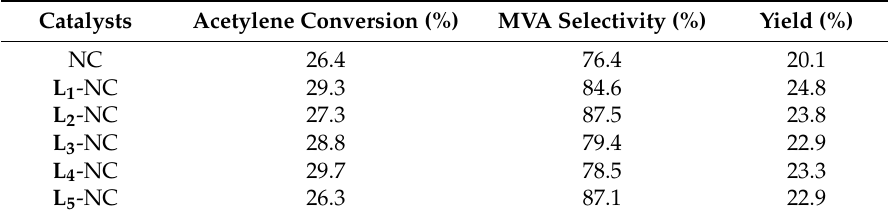
Table 1. Effect of L 1 – L 5 (3%) for acetylene